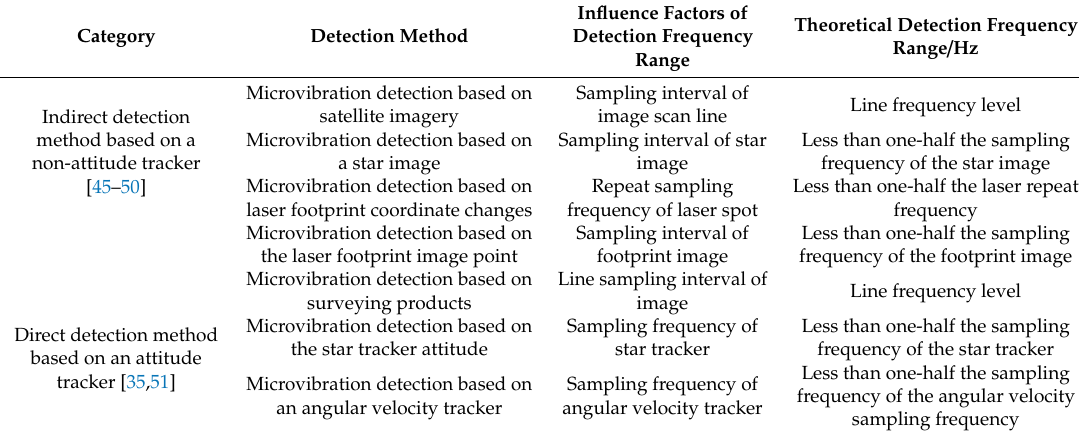
Table 2. Detection frequency range comparison.